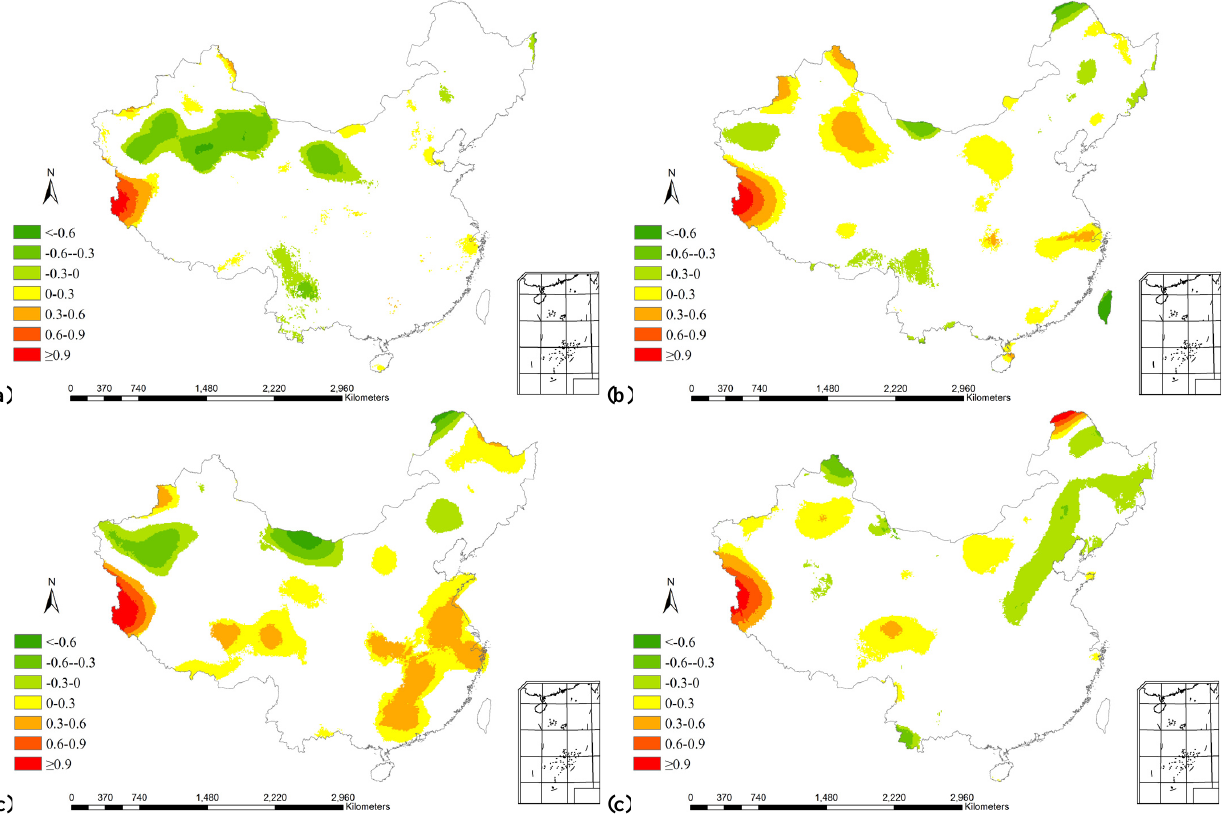
Fig. 6. Spatial distribution of changing rate of seasonal diffuse radiation in China from 1981 to 2010 (white areas denote that there are no statistically significant trends, α = 0 . 05. a , b , c and d denote spring, summer, autumn and winter. Unit: % per